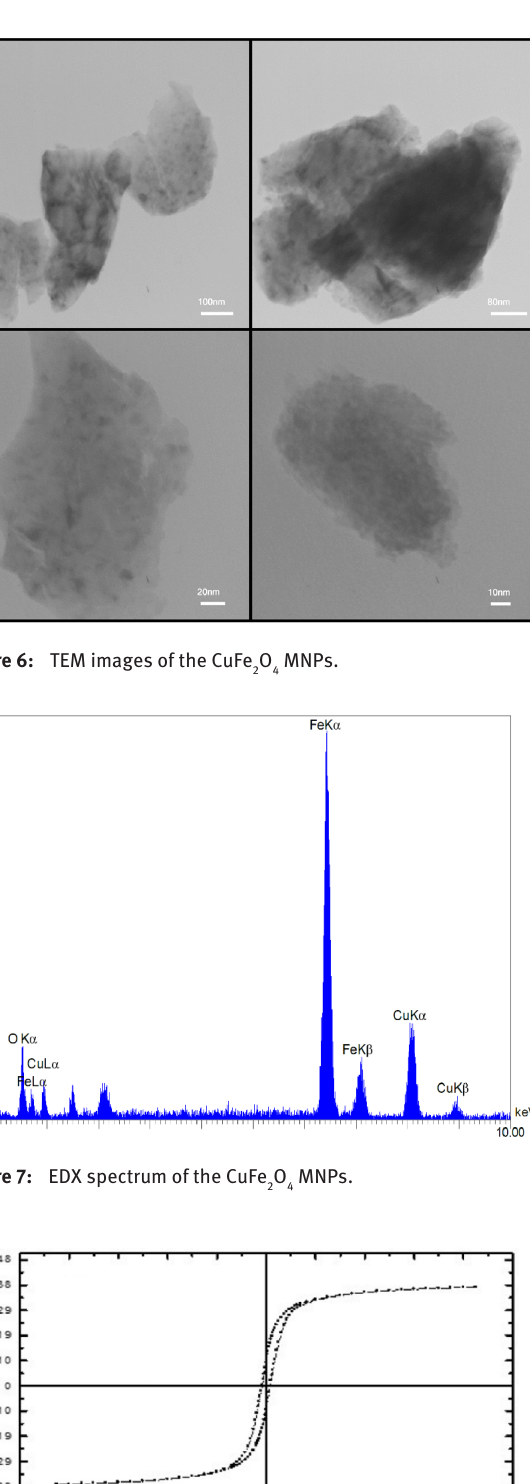
Figure 8: VSM spectrum of the CuFe